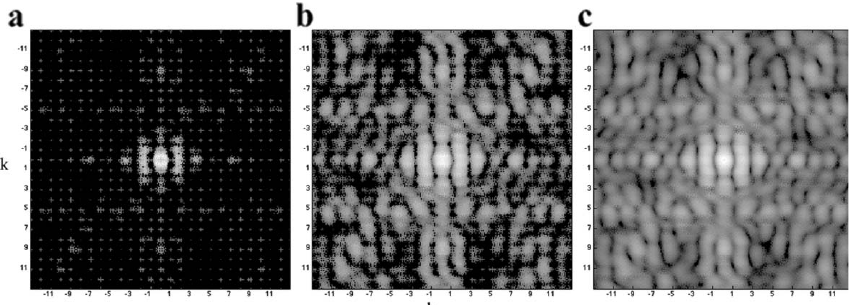
Figure 9 The recovered molecular transforms at different data ranges. The partial unit cells cover 20% of the boundary layer, i.e. f p = 0.2. The data ranges are 10 3 , 10 4 and 3 (cid:3) 10 4 for ( a ), ( b ) and ( c ), correspondingly. For a small data range, the weak scattering in inter-Bragg regions is not recovered ( a ); more intensities are recovered at medium data range [10 4 , in ( b )]; and, eventually, the recovered pattern is comparable to the results in the ideal case when the measurable data range gets to 3 (cid:3) 10 4 ( c ).